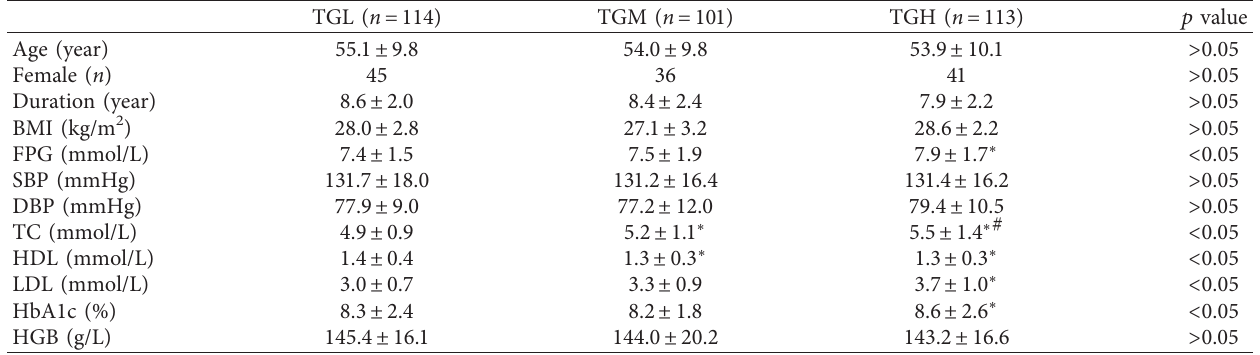
Table 1: Comparison of clinical data among patients with different TG